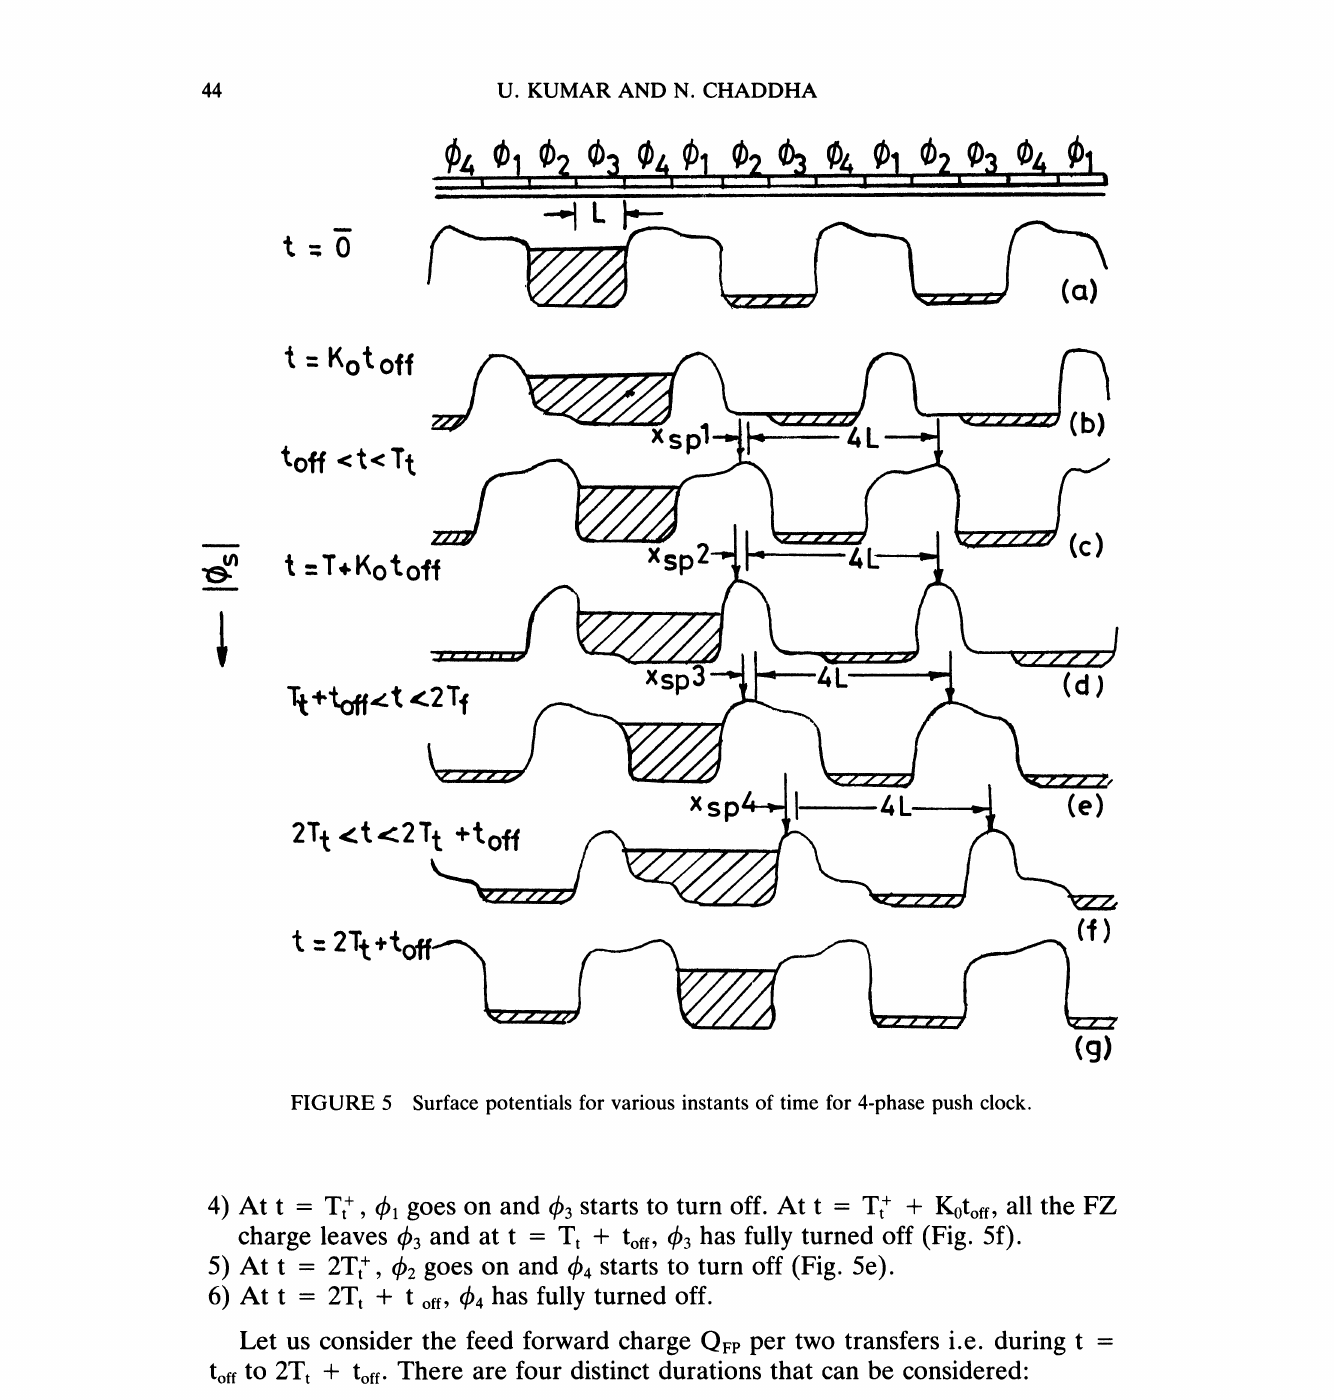
FIGURE 5 Surface potentials for various instants of time for 4-phase push